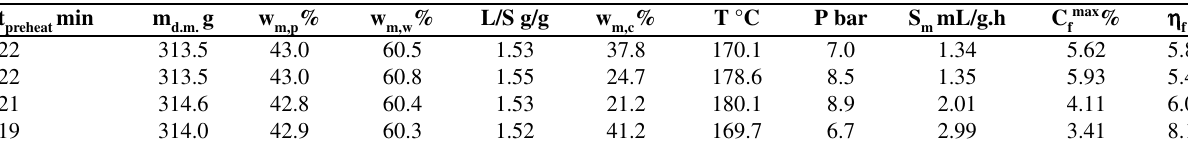
Table 3. Conditions and results of the catalysed (3.7% H process. 16 t preheat